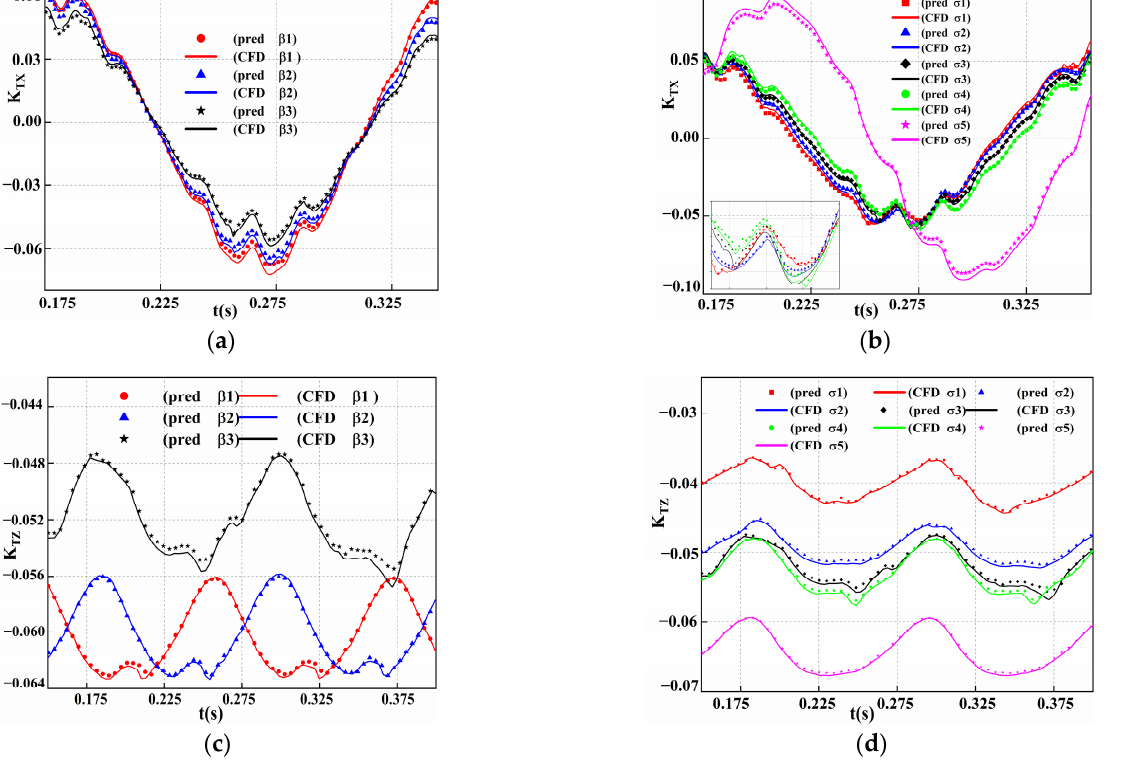
Figure 19. Difference of K TX and K TZ between the predicted value and CFD value. ( a ) Difference of K TX at different oblique angles. ( b ) Difference of K TX at different cavitation numbers. ( c ) Difference of K TZ at different oblique angles. ( d ) Difference of K TZ at different cavitation